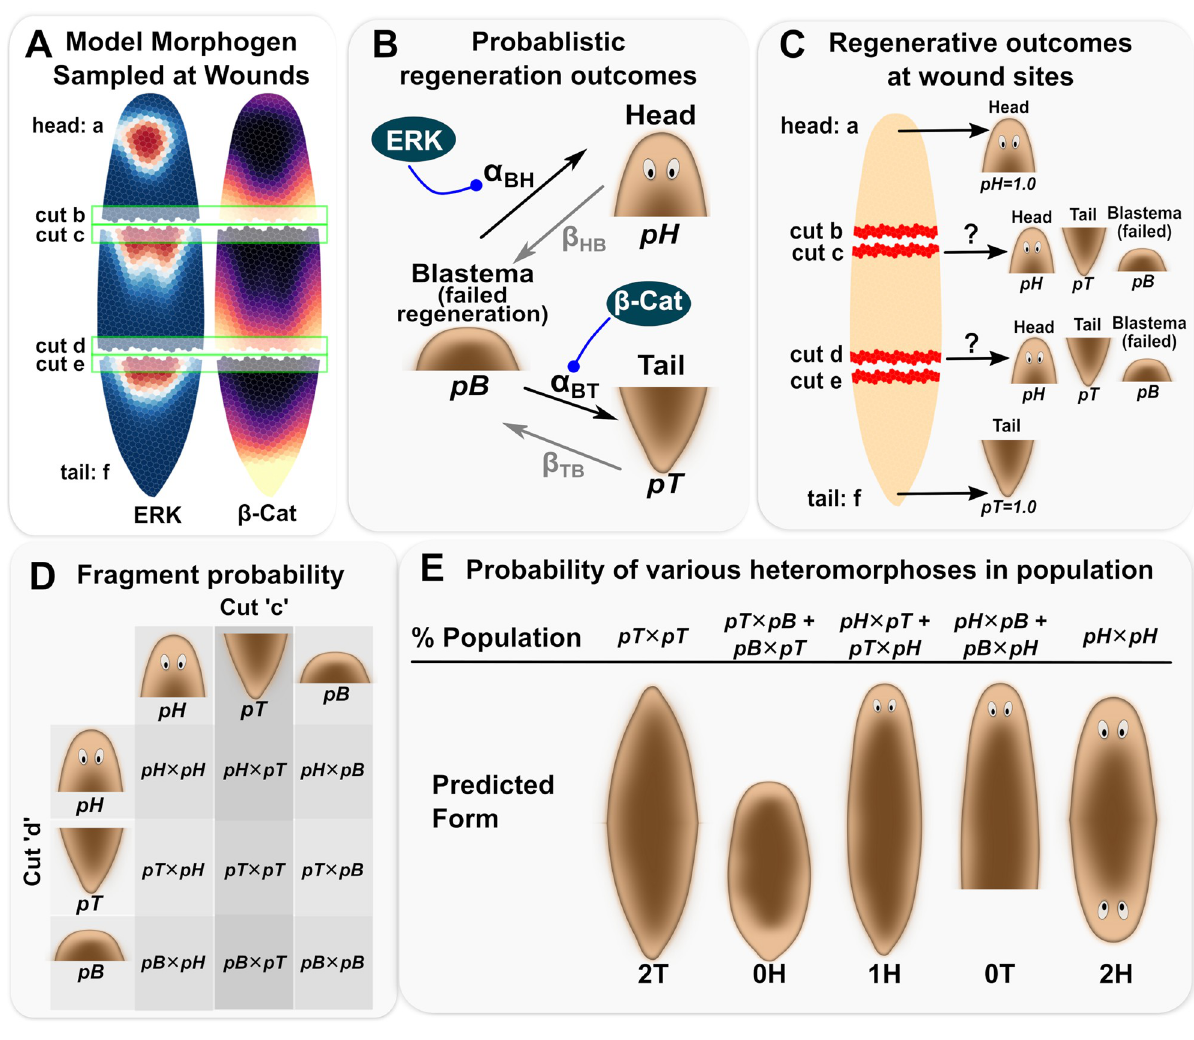
Fig 3. Key concepts underlying the Markov Chain Model of Regeneration used to predict regeneration outcomes from modeled steady-state morphogen concentrations averaged at the wound sites of the model. Concentrations of key instructive morphogens (ERK and β -Cat) were sampled and averaged at each model cut line (A). The base Markov Chain assumed possible transitions of the blastema at the cutting site into a potential head or tail, with the additional case that failure to transition to head or tail represents a failed regeneration (B). Head, tail, or blastema (failed) probabilities were represented by pH , pT , and pB , respectively (B, C). Transition rates from blastema to head ( α BH ) were assumed to be increased by ERK concentrations at the wound (B, Eq 3), while transitions from blastema to tail ( α ) were assumed to be increased by β -Cat concentrations at the wound BT (B, Eq 4). Regeneration outcomes at cut-lines were calculated probabilistically, where existing head and tail remained unchanged on top and bottommost fragments (C). To determine the frequencies of heteromorphoses in a particular fragment appearing in a population of regenerates, the probabilities of each possible outcome at each cut line of the fragment were multiplied (D). The respective predicted fraction of heteromorphoses appearing in the population were inferred from the combinations shown in (D), where the possible heteromorphoses and their net probabilities are shown in